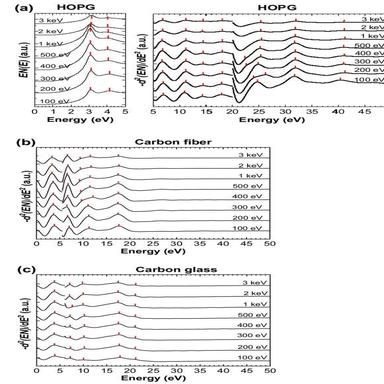
(a) Fine structures of SES spectra for HOPG: The fine structure of 0-5 eV is obtained directly in the EN(E) spectrum (left), and that of 5-50 eV is obtained by the negative second-order differentiation (right). Fine structures for (b) carbon fiber and (c) carbon glass in the second-order differentiation. The red line segments indicate the position of fine structures.